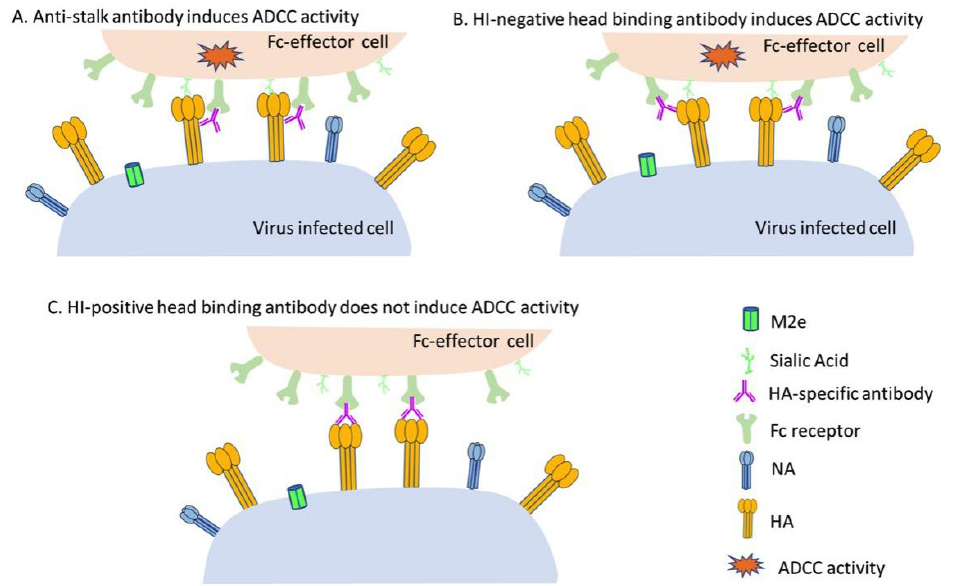
Figure 3. Two synapses between e ff ector cell and virus-infected cell are essential for robust ADCC activities. The interaction between Fc and Fc γ RIIIa severs as the first synapse and the interaction between viral HA head and the sialic acid on e ff ector cell form the second synapse, which are indispensable for inducing potent ADCC activities ( A , B ). The HI-positive antibody may interfere with the interaction between viral HA head and the sialic acid on e ff ector cell, leading to weak ADCC activity ( C ). HI assay was extensively performed to determine the e ff ects of antibodies in blocking the receptor engagement and replication of the viruses. However, this evaluation may be challenged by some emerging influenza viruses that lack the ability to agglutinate red blood cells of various animal origins [107]. In this scenario, the cell-based virus-neutralization assay would be suitable for the characterization of RBS binding antibodies.